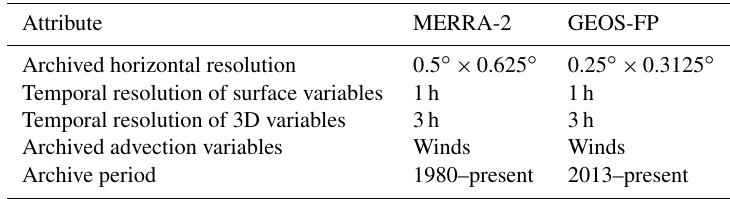
Table 1. GMAO data products used by GEOS-Chem at the start of this work.